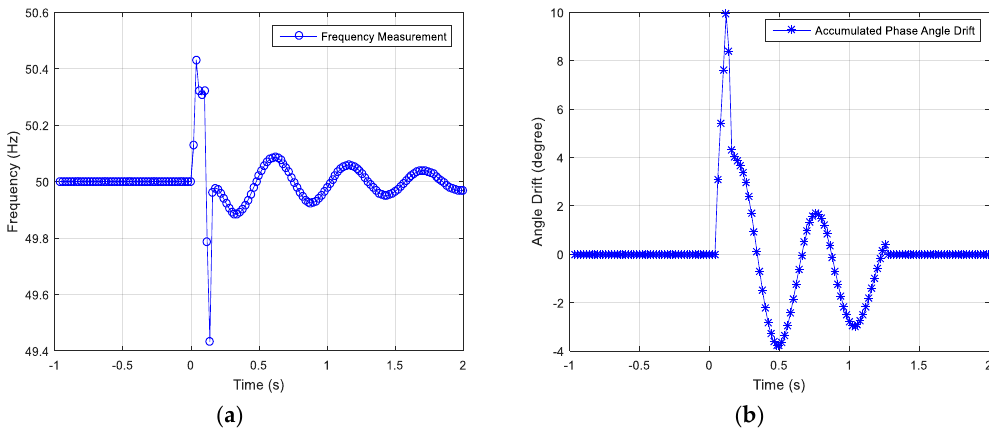
Figure 9. ( a ) Frequency measurement ; ( b ) accumulated phase angle drift under three phases fault and the frequency oscillation after fault clearance.